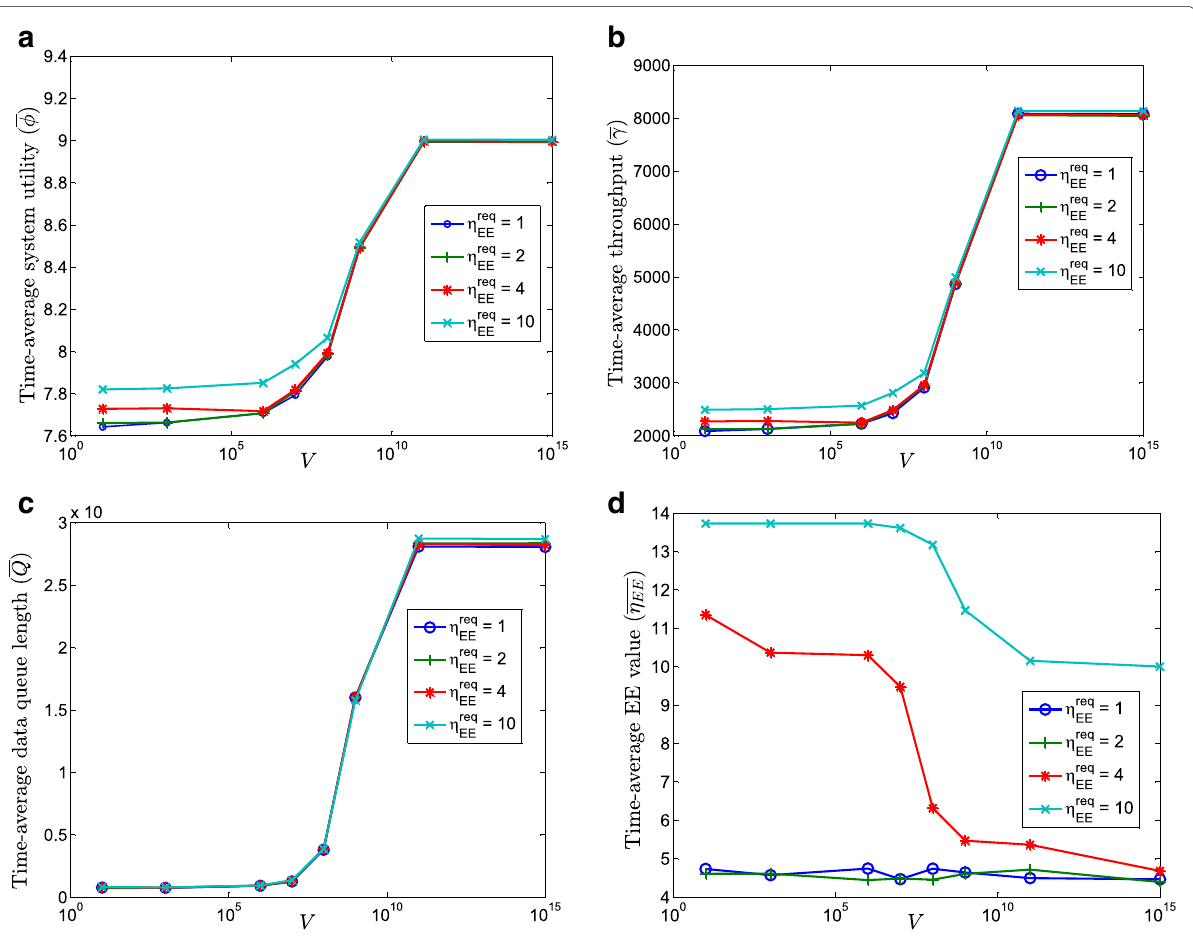
Fig. 3 Impacts of varying V upon the time-average a utility φ , b throughput γ , c data queue length Q , and d energy efficiency η